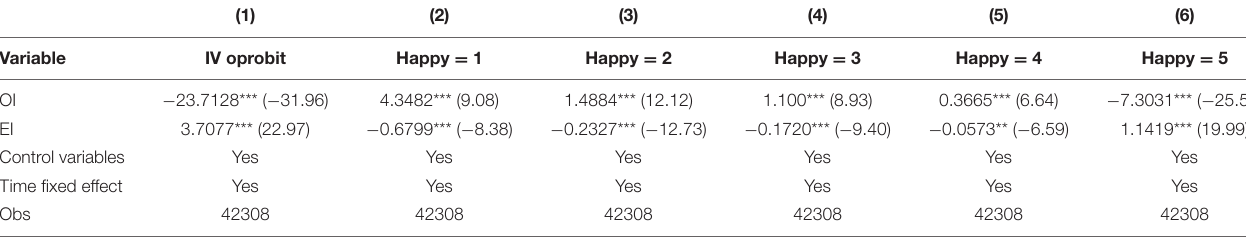
TABLE 5 | The regression results with instrument variables.